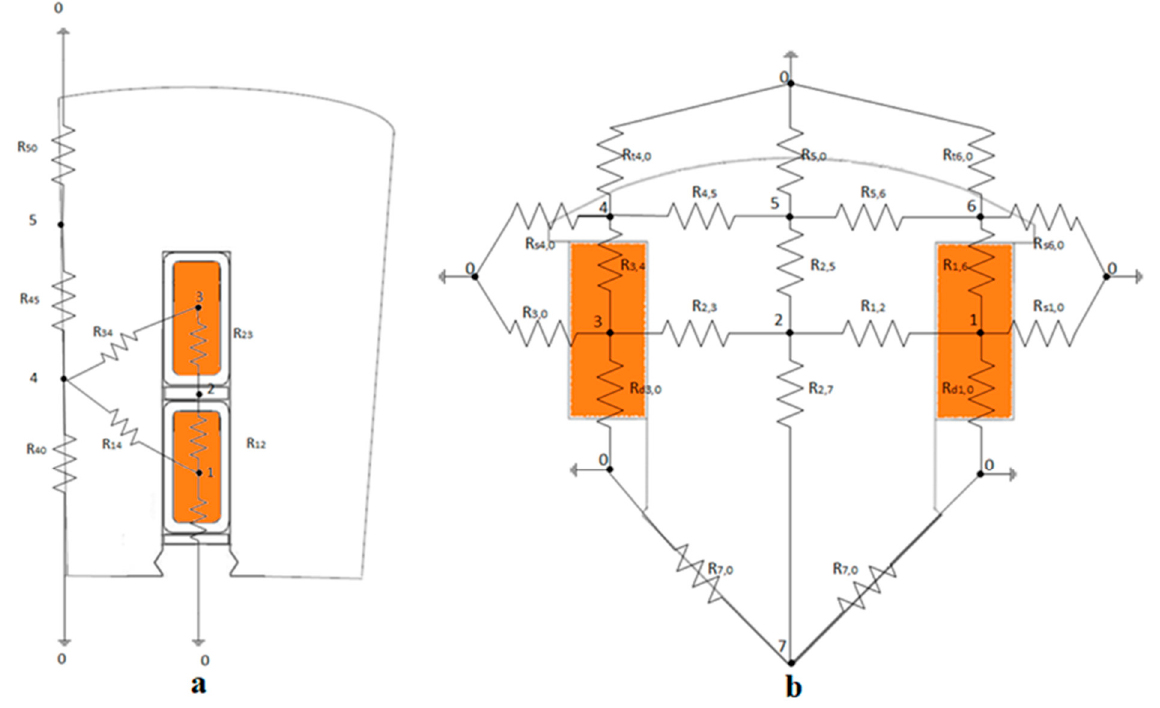
Figure 2. The proposed radial model: ( a ) stator; ( b ) rotor.